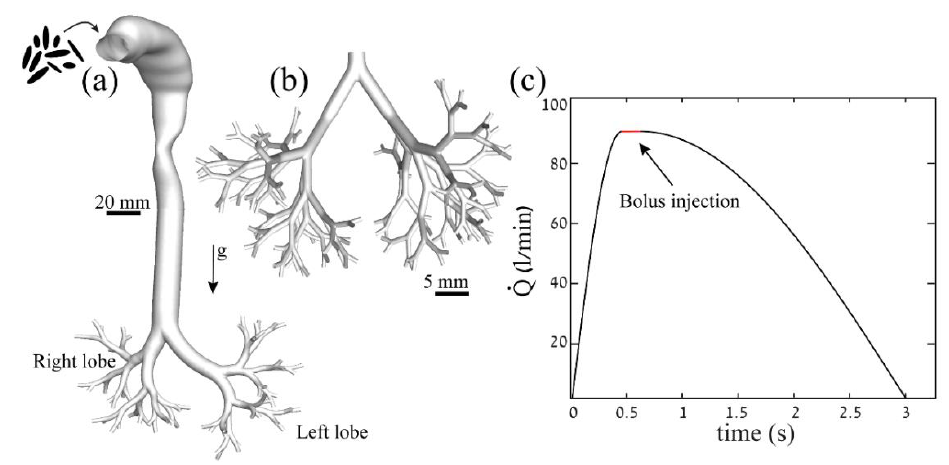
Figure 1. Schematic of the lung domains and dry powder inhaler (DPI) flow profile. ( a ) The in silico upper airways model consists of a mouth and throat, trachea, and 7 generations of the conducting airways, following [25]. ( b ) The bronchial tree model consists of 9 symmetrical generations of the bronchial airways, following [23]. ( c ) Profile of the DPI inhalation maneuver (i.e., flow rate) through the mouth as a function of time. Particle injection (marked in red) is confined to a short bolus, spanning 0.45 to 0.6 s [25].